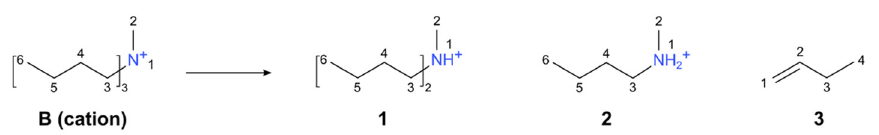
Scheme 1. Decomposition pathways of cation TBuMA. The labeling on each compound is used for the assignment of the NMR signals.